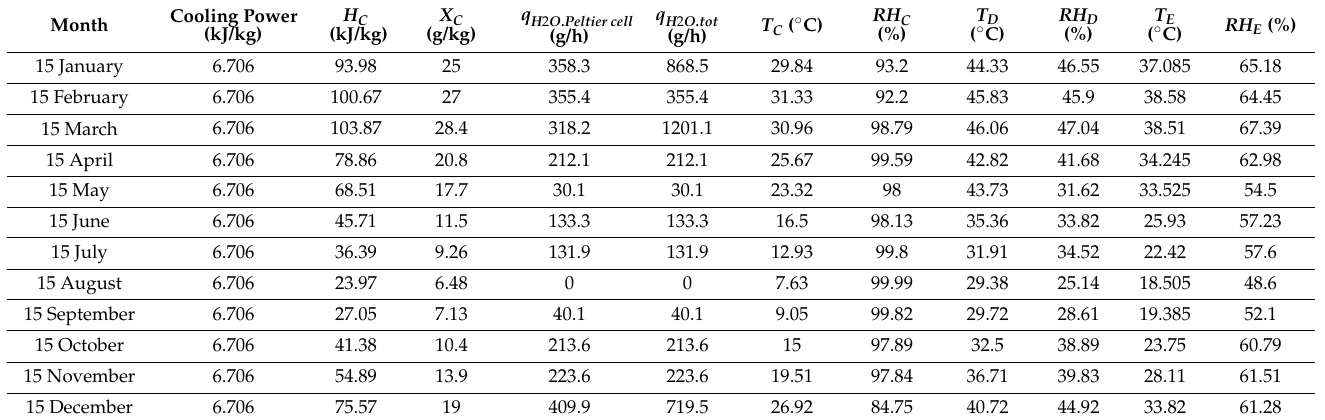
Table 5. Calculation of condensed water using 1 Peltier cell.